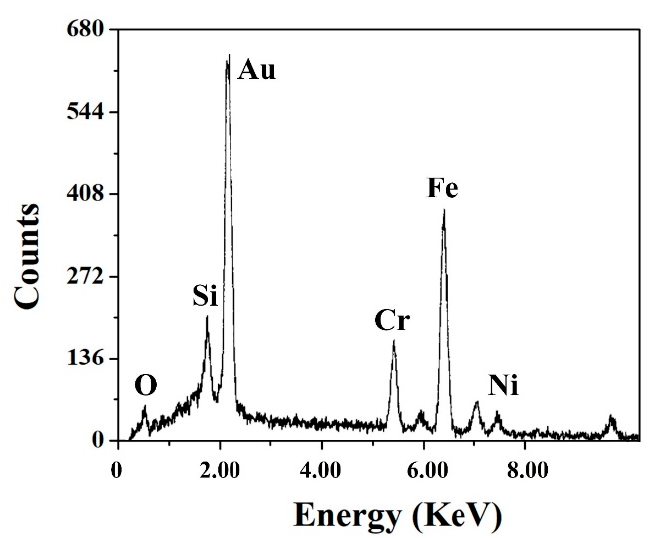
Figure 15. The energy-dispersive spectrometer (EDS) results for zone